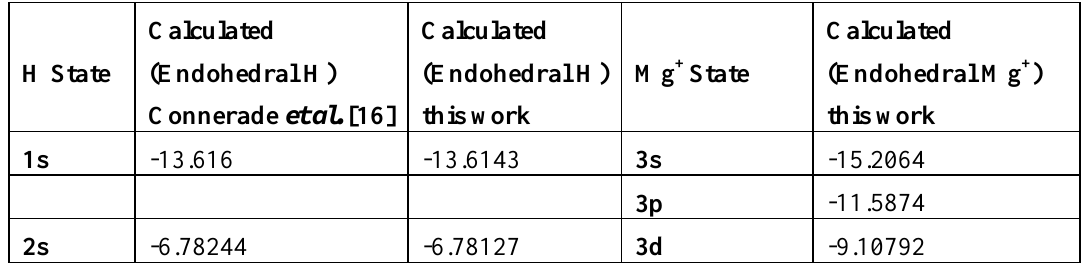
Table IV. Our calculated values for selected energy levels in H and Mg + in the jellium- shell cage, along with those for H calculated by Connerade et al. [16]. All energies are in eV and calculated so that the free electron has energy E=0 . States do not correspond across